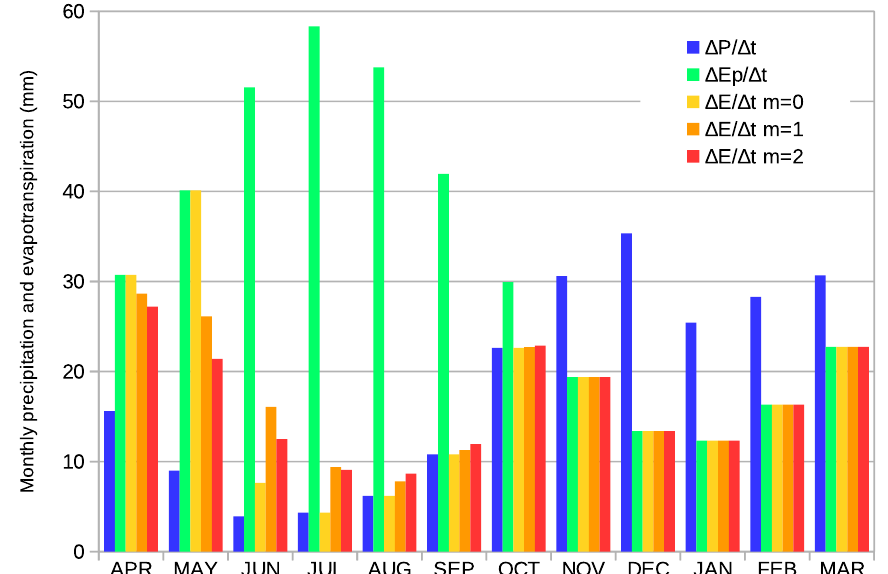
Figure 14. Hydrological balance for agricultural soil according to Thornthwaite. Three soil dissecation laws were considered according to Equation (1) for m = 0, 1, 2. Derived from NASA Power dataset of monthly temperatures and precipitations from 1984 to 2013.